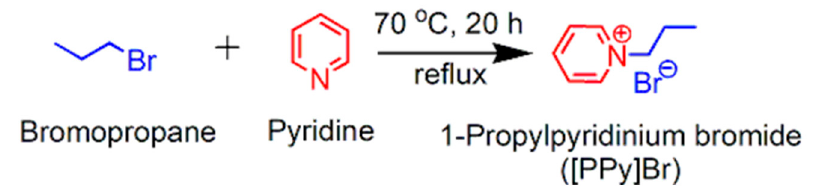
Figure 11. ( a ) Comparison of catalytic activity between synthesized SAPO-11 and conventional homogeneous acids and ( b ) SAPO-11 catalyst reusability test. Reaction conditions: T = 180 °C, t = 30 min, levulinic acid:ethanol ratio = 1:11, m SAPO-11 = 0.100 g (17.98 μ mol) equivalent to 0.0017 g of HCl, 0.0018 g of H 2 SO 4 , 0.0011 g of CH 3 COOH and 0.0035 g of p -toluenesulfonic acid (PTSA).